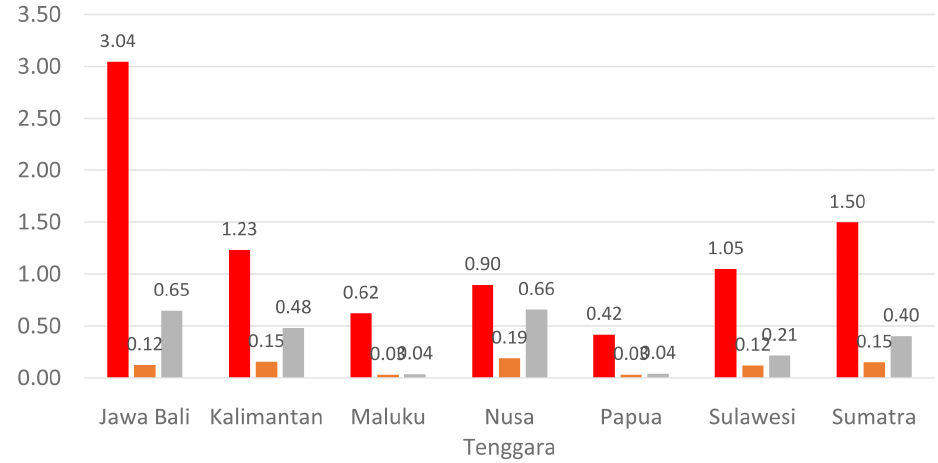
Figure 1. Distribution of dentists (red), dental therapists (orange) and dental technicians (grey) in Indonesia (x axis is island name in Indonesia; y axis is the average number of dental health personnel per public health center).